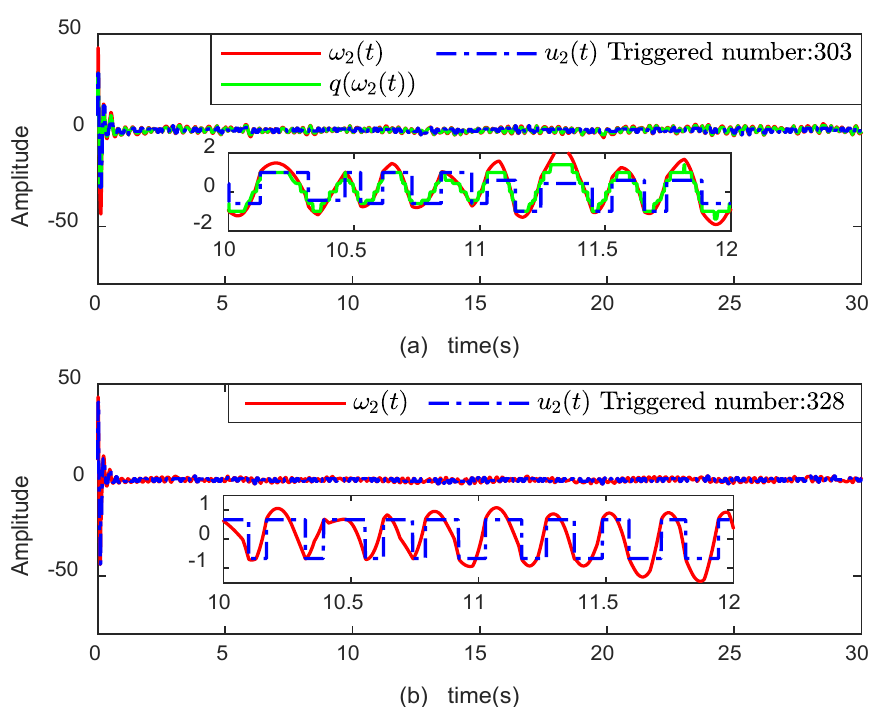
Figure 9. The trajectories of ω 2 , q ( ω 2 ) , and u 2 . ( a ) with quantized control. ( b ) without quantized control.